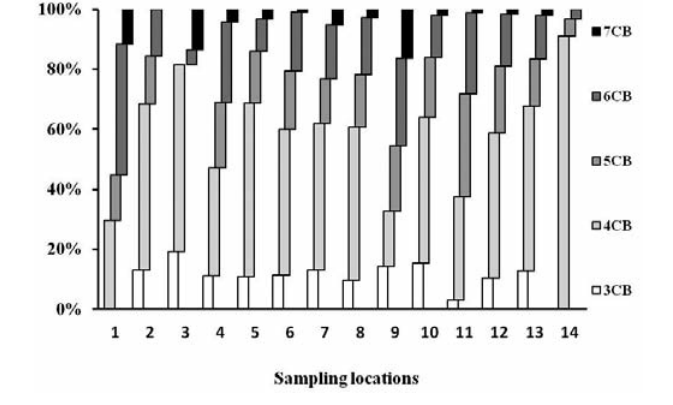
Figure 1. Polychlorinated biphenyl homologs in soil at different locations in Delhi, India.